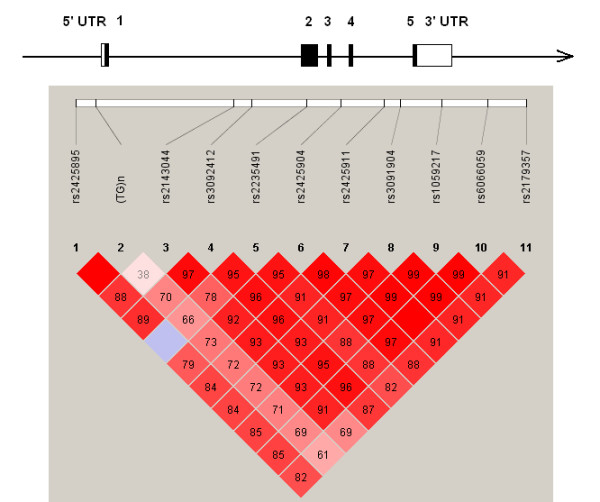
Graphical representation of SNPs in relation to the exon-intron structure (upper part) and Haploview LD graph of SCL2A10 gene (lower part). The exon regions are shown with filled rectangles and numbered in order. Pairwise LD coefficients D' × 100 was shown in each cell (D' values of 1.0 were not shown). Standard color scheme of Haploview was applied for LD color display (LOD score > 2 and D' = 1 in bright red; LOD score > 2 and D' <1 in blue; LOD score <2 and D' = 1 in shade of pink; LOD score <2 and D' <1 in white).